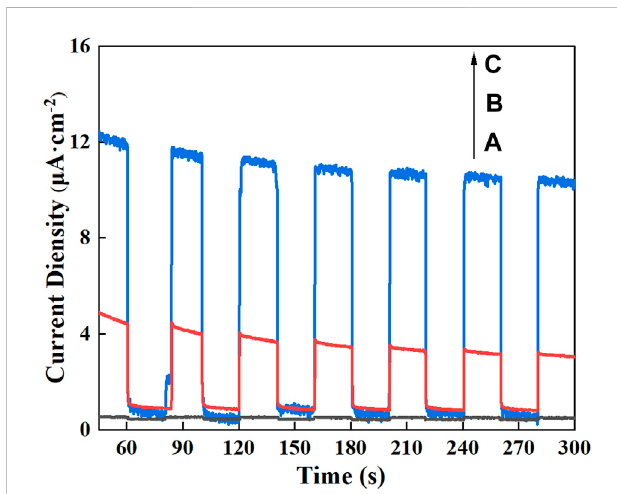
FIGURE 7 Transient photocurrent densities of TiO 2 (A) , N-TiO 2 @Oys (B) and CeNT@Oys (C) electrodes with light on/off cycles under visible